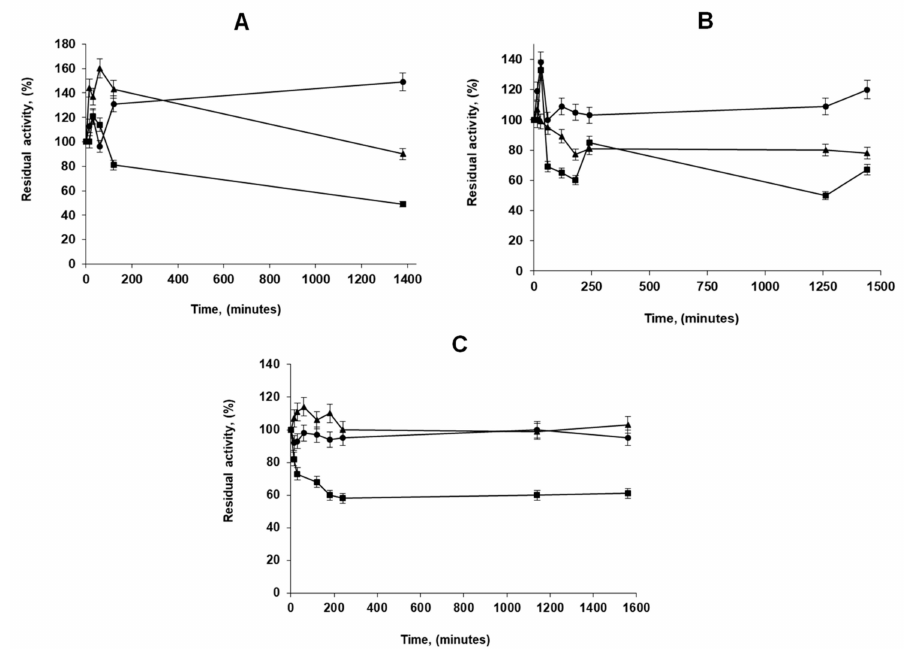
Figure 3. Inactivation profile of di ff erent lipase preparations incubated in the presence of 30% ( v / v ) of di ff erent cosolvents. Acetonitrile ( A ); 1,4-dioxane ( B ); and dimethylformamide ( C ). The experiments were performed at pH 7 and 25 ◦ C as described in Methods. Solid circles: octyl-PFL; solid triangles: octyl-RML; and solid squares: